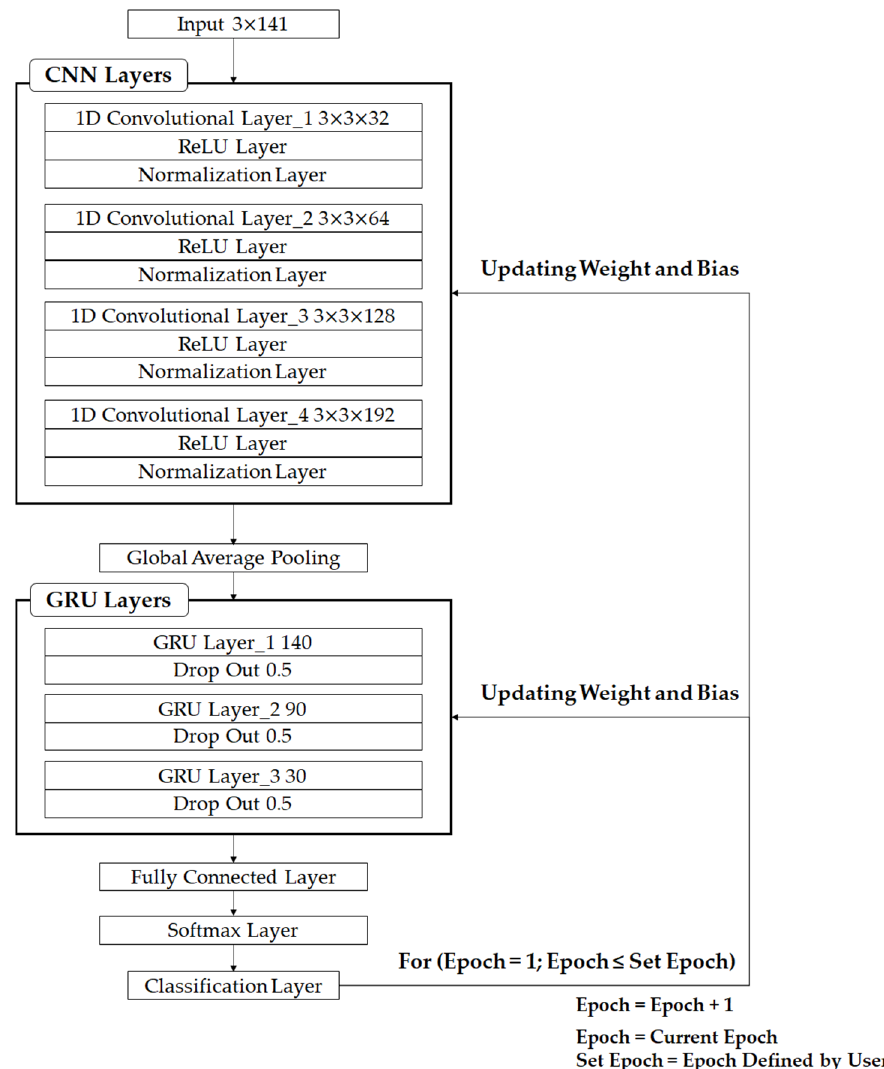
Figure 5. The architecture of the optimized 1D CNN–GRU for the RCS measurement classification.